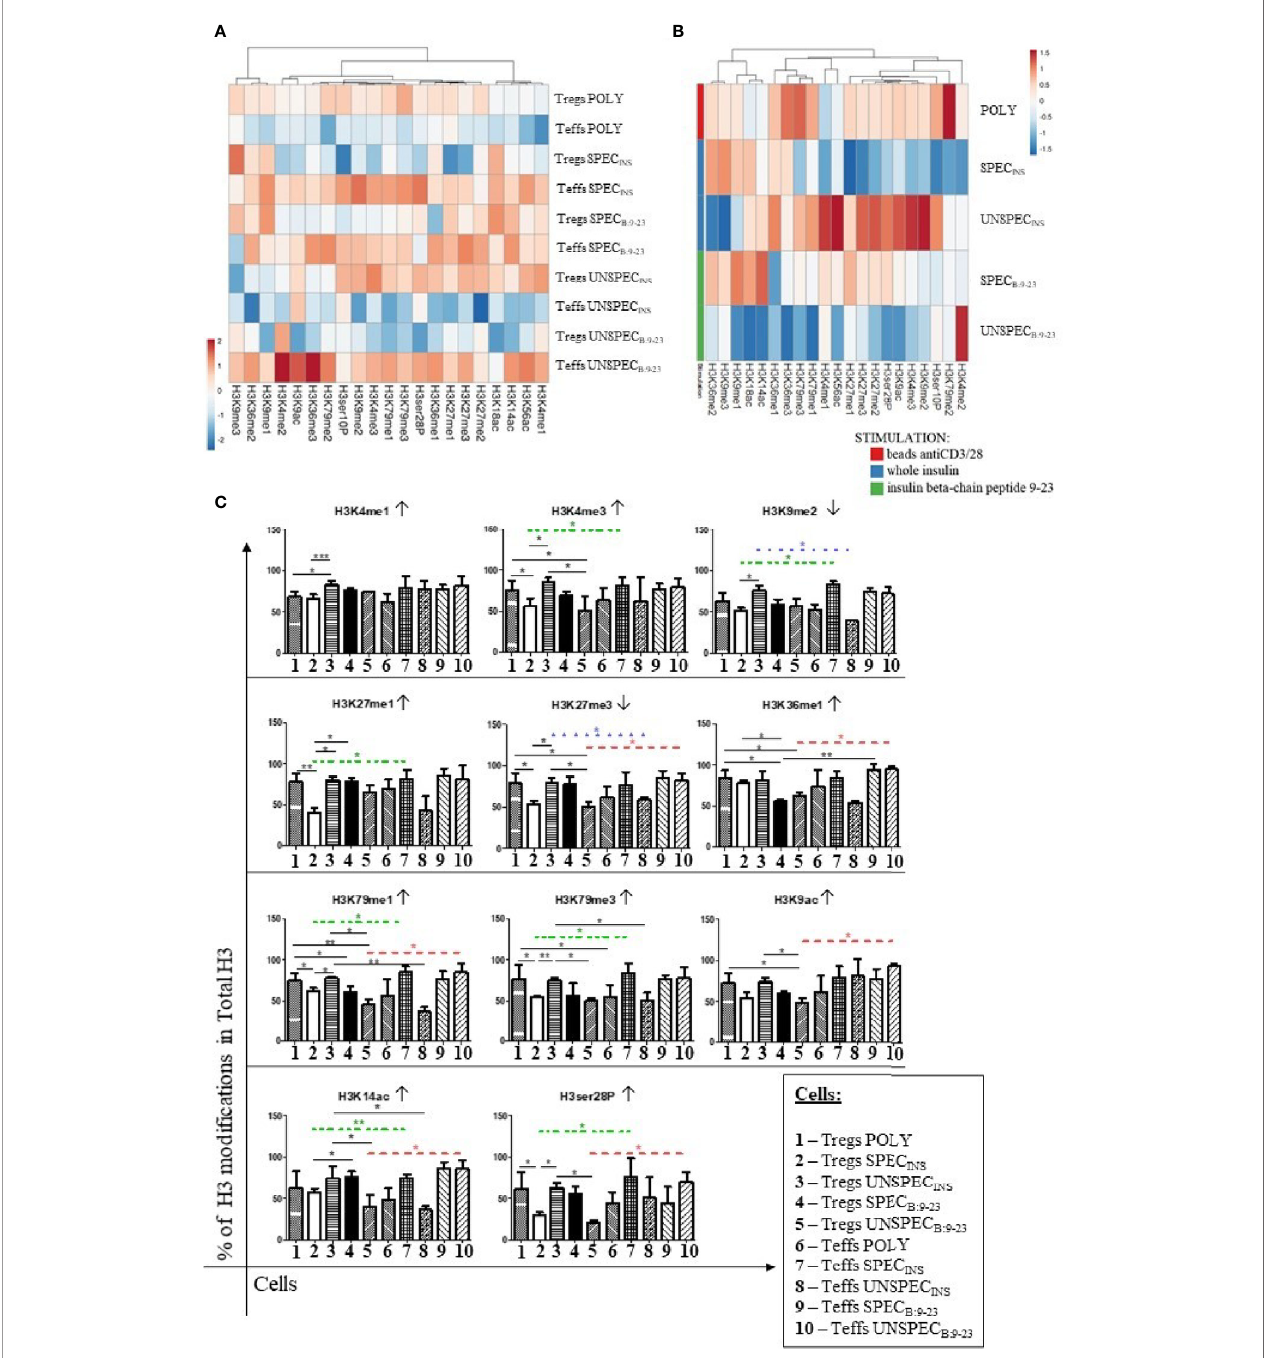
FIGURE 6 | Percentage of histone H3 modi fi cation in total H3 in Tregs and Teffs. (A) Comparison of percentage of modi fi cations in Tregs: POLY, SPEC, UNSPEC and Teffs: POLY, SPEC, UNSPEC. (B) Comparison of modi fi cations only in Tregs. Cells were stimulated with anti-CD3/anti-CD28 beads (index POLY) or monocytes loaded with whole insulin (INS) or insulin b chain peptide 9-23 (B:9-23). (C) Graphs presenting changes in cells populations. Only modi fi cations in which statistical signi fi cance occurs are presented. Cells responding to the antigen have an index SPEC, cells not recognizing the antigen have an index UNSPEC. All analyzes were performed for six tests (three tests for whole insulin and three tests for insulin b chain peptide 9-23) in triplicate. The results are presented as mean+/- SD. Signi fi cance was calculated using the t- test, signi fi cant results are marked with * (p<0.05), ** (p<0.01) or *** (p<0.001). Heat maps were prepared using ClustVis tool based on correlation distance and average linkage between clusters (21). ↑ - activating modi fi cation; ↓ - inactivating modi fi cation; ···· difference between speci fi c Tregs and Teffs stimulated with insulin; ···· difference between unspeci fi c Tregs and Teffs stimulated with insulin; ···· difference between unspeci fi c Tregs and Teffs stimulated with peptide